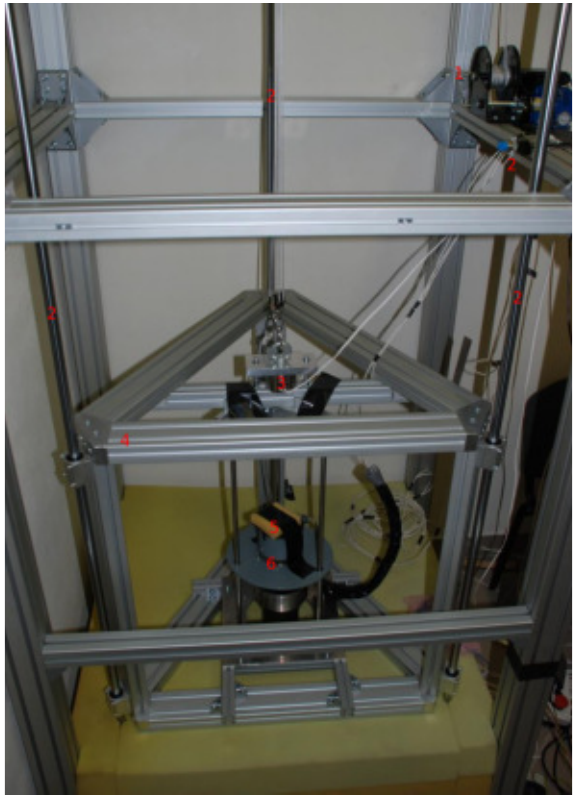
Figure 1. Drop tower setup (1 - motorized drop- weight lift, 2 - trigger inductive sensor, 3 - guide rods, 4 - electromagnetic release member, 5 - drop-weight guide frame, 6 - accelerometer, 7 - drop-weight).